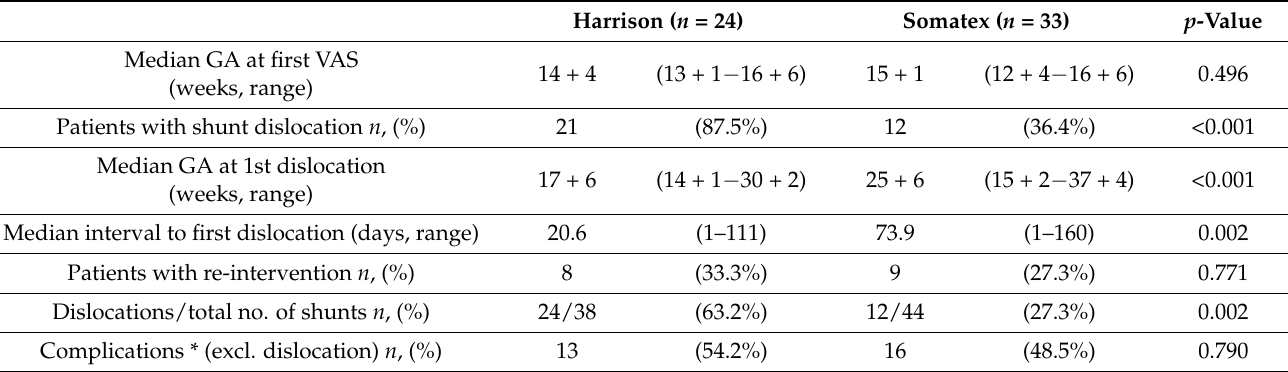
Table 1. Patient characteristics and shunt-related complications by type of shunt.